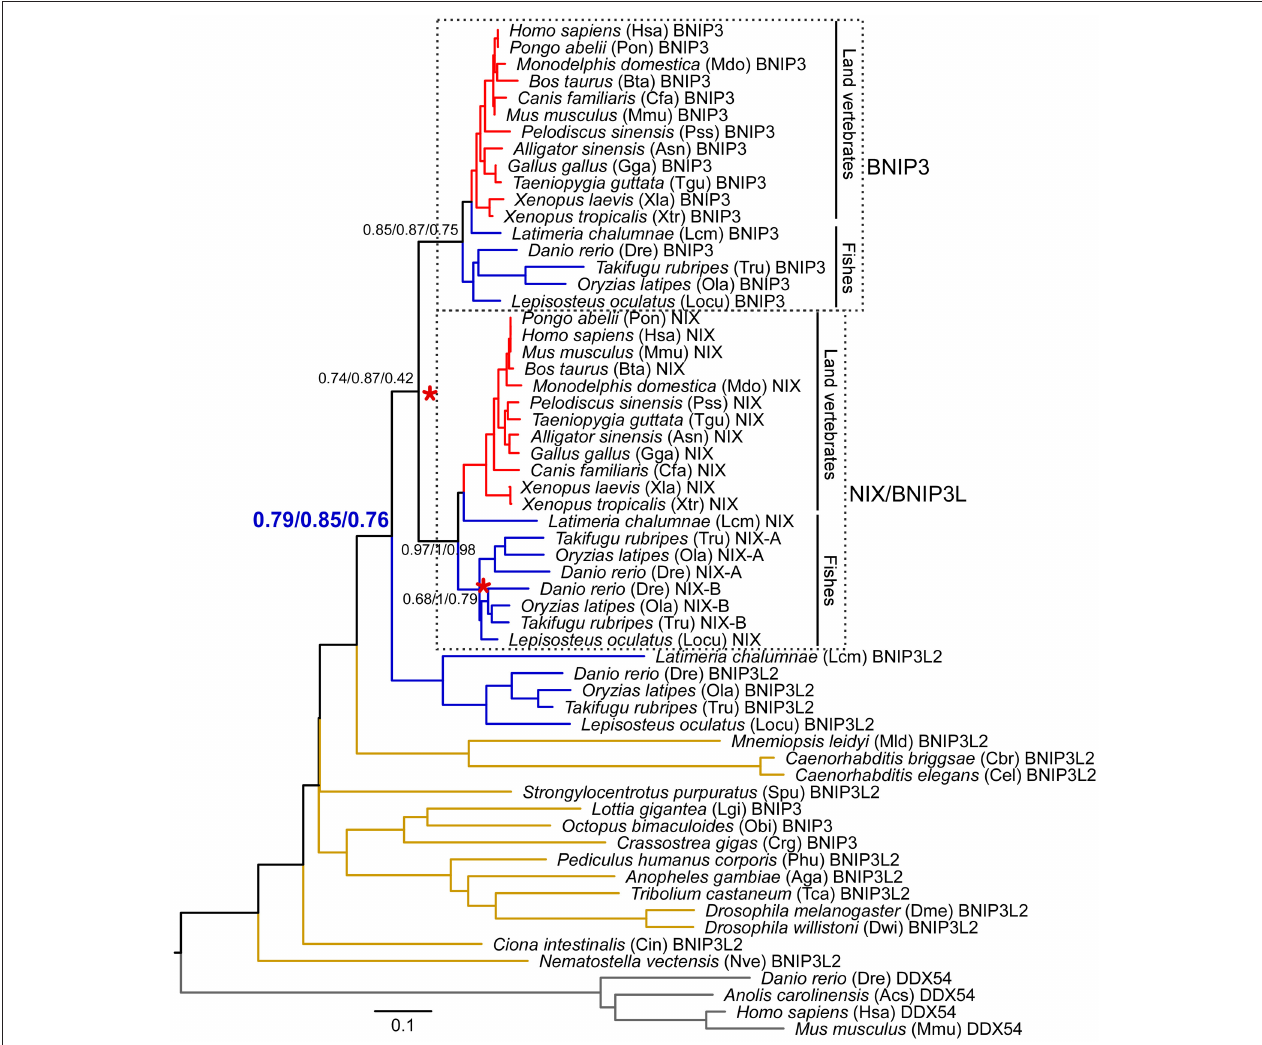
FIGURE 5 | Phylogeny of BNIP3 domain-containing proteins in animals. 56 BNIP3 domain-containing proteins are present in the 32 sampled animal species. Four DDX54 proteins were set as the outgroup to root the gene tree. The full-length sequences were aligned using MAFFT with the L-INS-i method. The tree topology is derived from a neighbor-joining tree. Statistical support values corresponding to neighbor-joining bootstrap, Bayesian posterior probability, and maximum-likelihood aLRT values are shown next to the corresponding nodes. The unit of branch length is the expected fraction of amino acid substitutions. Each leaf node is depicted as a full species name, followed by a three- or four-letter abbreviation of the species name and a gene ID. Vertebrate- and teleost-specific WGDs are marked with red asterisks. Branches in red, blue, and brown denote land vertebrates, fishes, and invertebrates, respectively. Branches of BNIP3 and NIX (also named BNIP3L) in land vertebrates and fishes are also indicated with black lines. The clades clustering vertebrate BNIP3 and NIX subfamilies are enclosed within dashed boxes and are included in molecular evolutionary and functional divergence analyses. Detailed protein information is noted in Supplementary Table 1. Proteins sequences